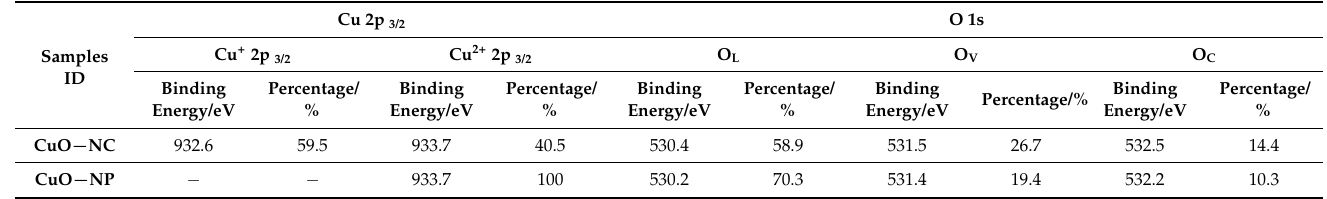
Table 1. The results of curve fitting of Cu 2p 3/2 and O1s XPS spectra of nano −